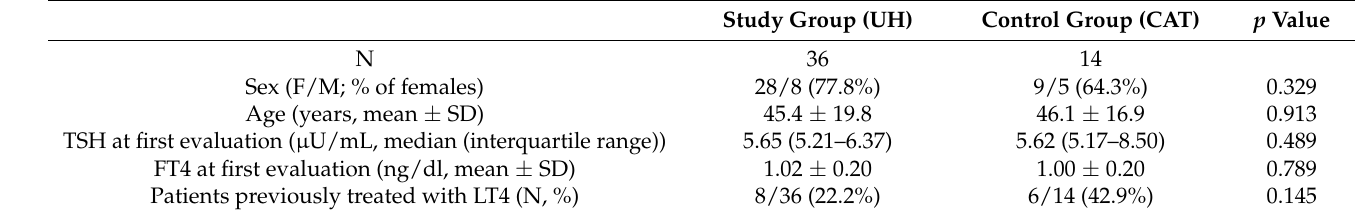
Table 1. Clinical and biochemical characteristics of unexplained hyperthyrotropinemia (UH)